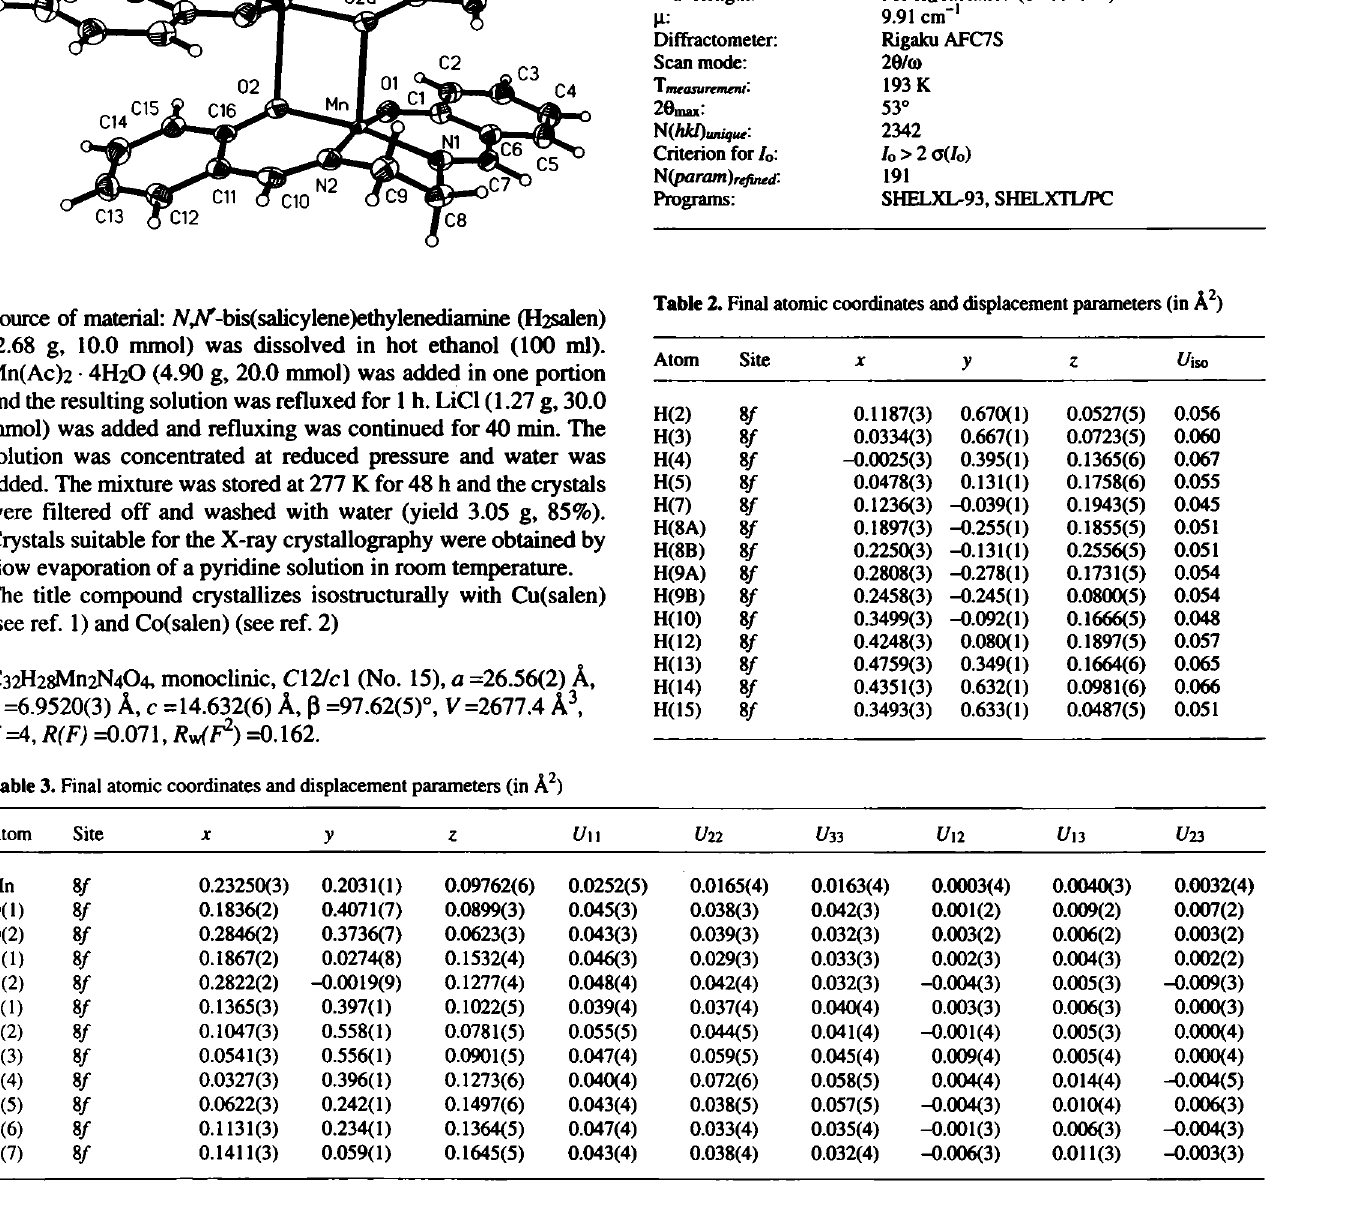
Table 2. Final atomic coordinates and displacement parameters (in